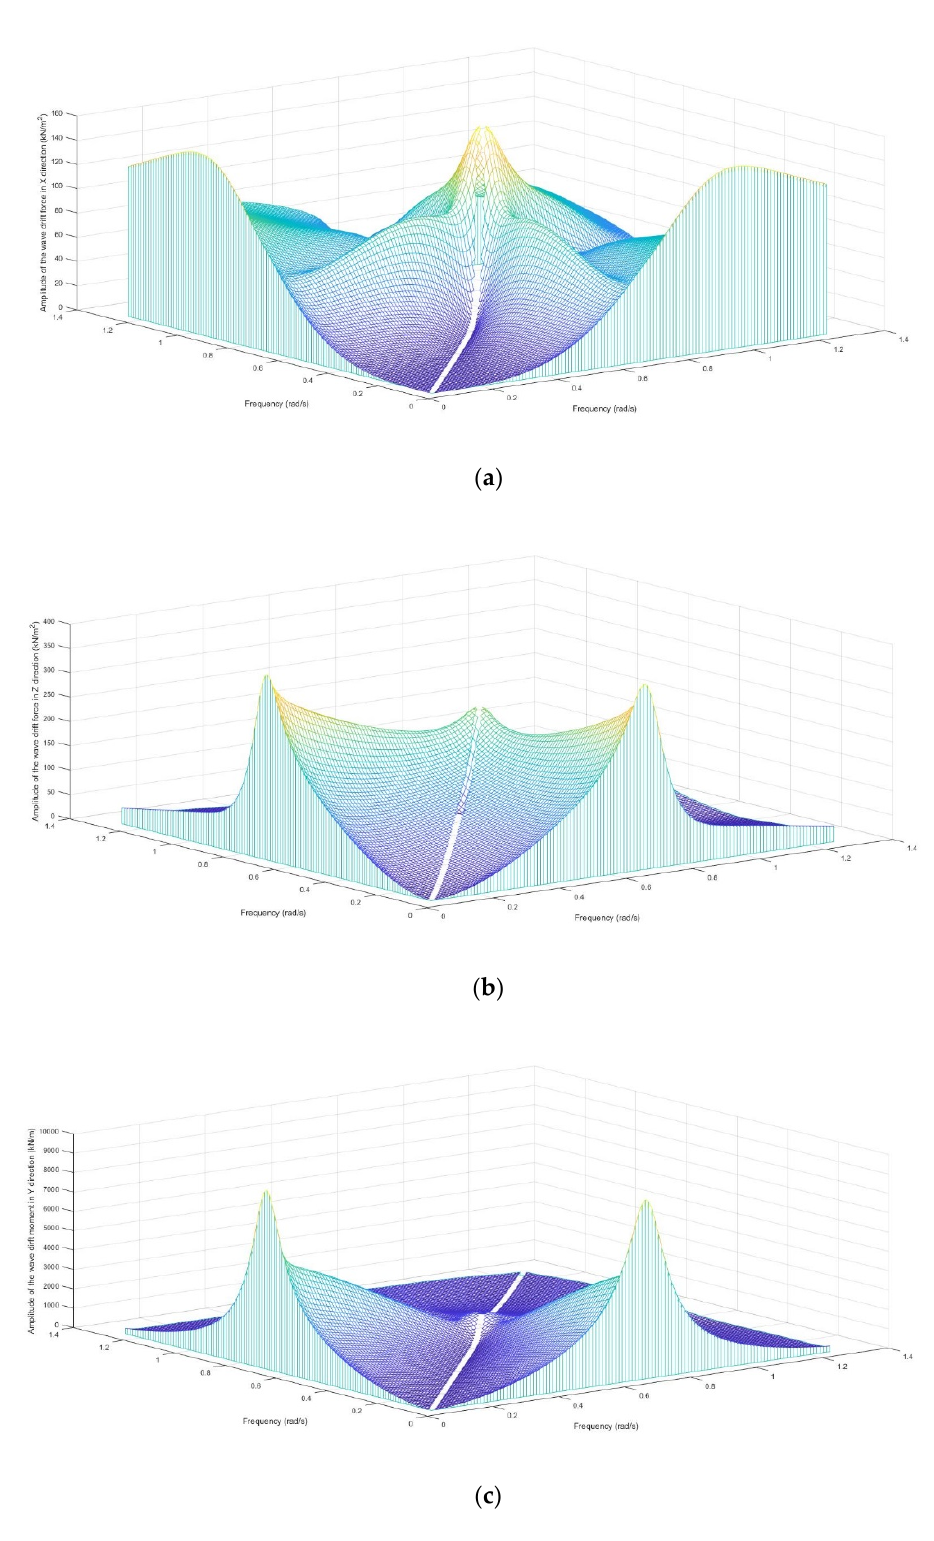
Figure 2. The amplitudes of the drift force coefficients with respect to wave frequencies (rad/s): ( a ) Amplitude of the wave drift force in X direction (kN/m 2 ); ( b ) Amplitude of the wave drift force in Z direction (kN/m 2 ); ( c ) Amplitude of the wave drift moment in Y direction (kN/m).